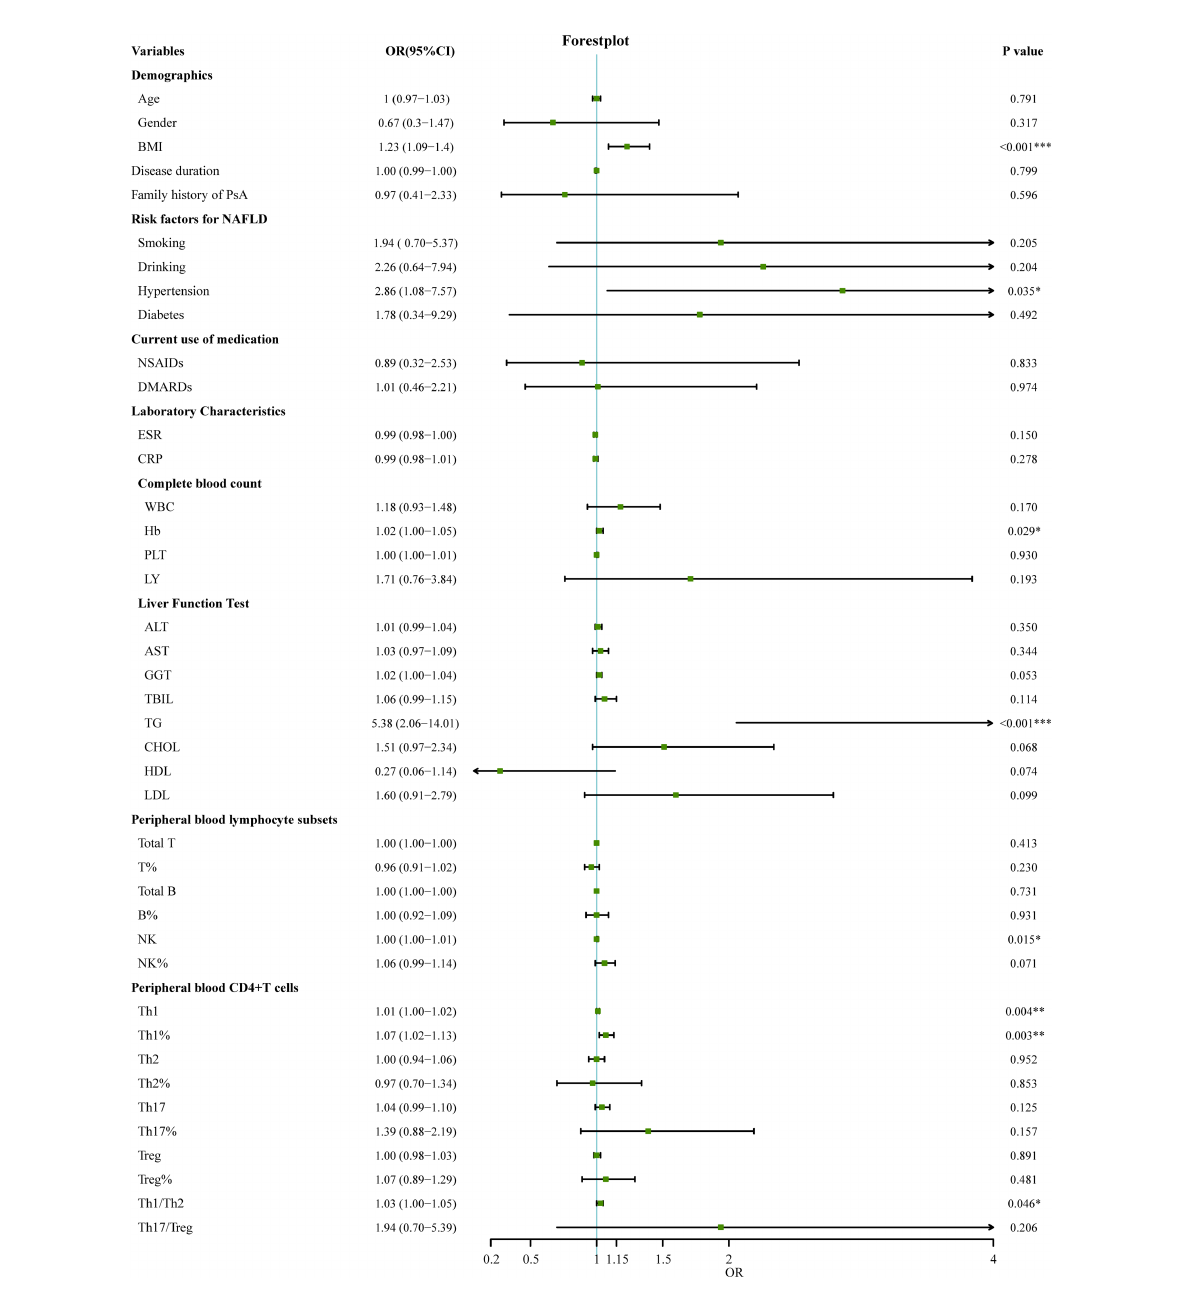
FIGURE 2 Univariate logistic regression analyses for factors associated with the presence of NAFLD in PsA patients. (* p < 0.05, ** p < 0.01, *** p < 0.001). OR, odds ratio; 95%CI:95% con fi dence interval; BMI, Body Mass Index; DMARDs, disease-modifying antirheumatic drugs; NSAID, nonsteroidal anti-in fl ammatory drug; ESR, erythrocyte sedimentation rate; CRP, C-reactive protein; WBC, white blood cells; Hb, Hemoglobin; PLT, platelets; LY, lymphocytes; ALT, Alanine transaminase; AST, Aspartic transaminase; GGT, Gamma-glutamyltransferase; TBIL, Total bilirubin; TG, Triglycerides; CHOL, Cholesterol; LDL, Low-density lipoprotein; HDL, High-density lipoprotein; T, T lymphocyte; B, B lymphocyte; NK, natural killer cell; Th1, T-helper 1 cells; Th2, T-helper 2 cells; Th17, T-helper17 cells; Treg, regulatory T